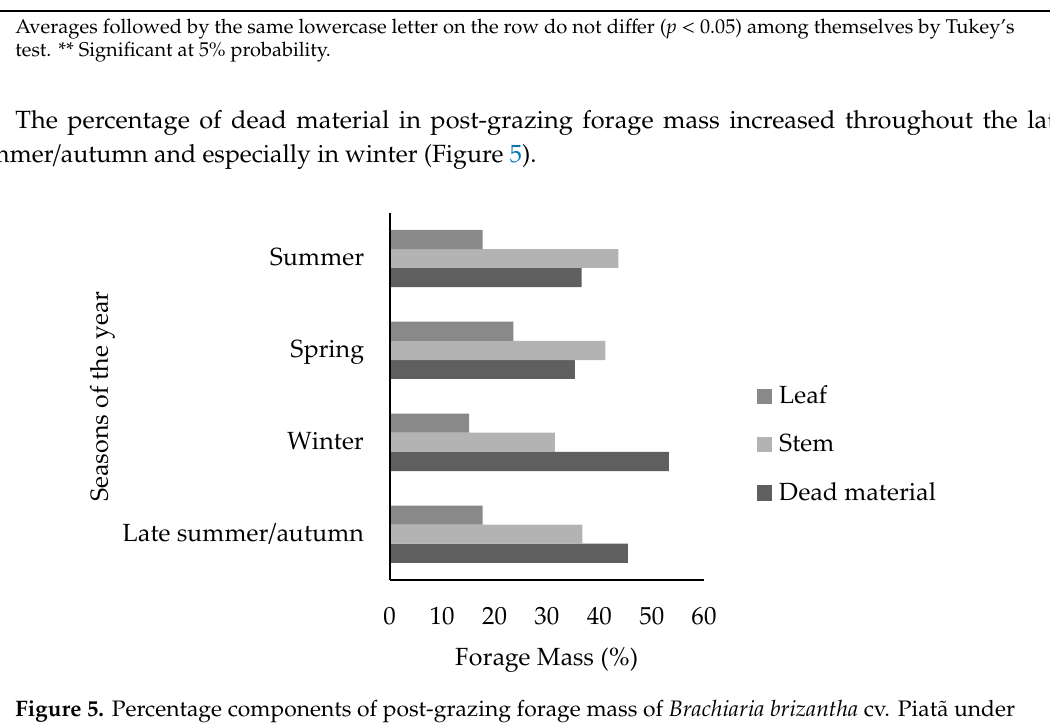
Figure 5. Percentage components of post-grazing forage mass of Brachiaria brizantha cv. Piatã under rotational stocking and fertilized with nitrogen.